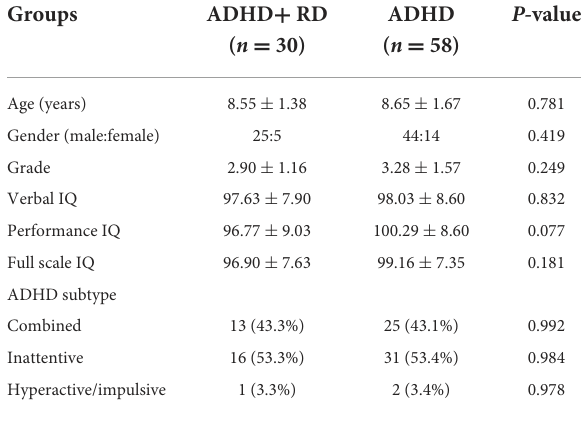
TABLE 1 Basic information of the ADHD + RD and ADHD groups.